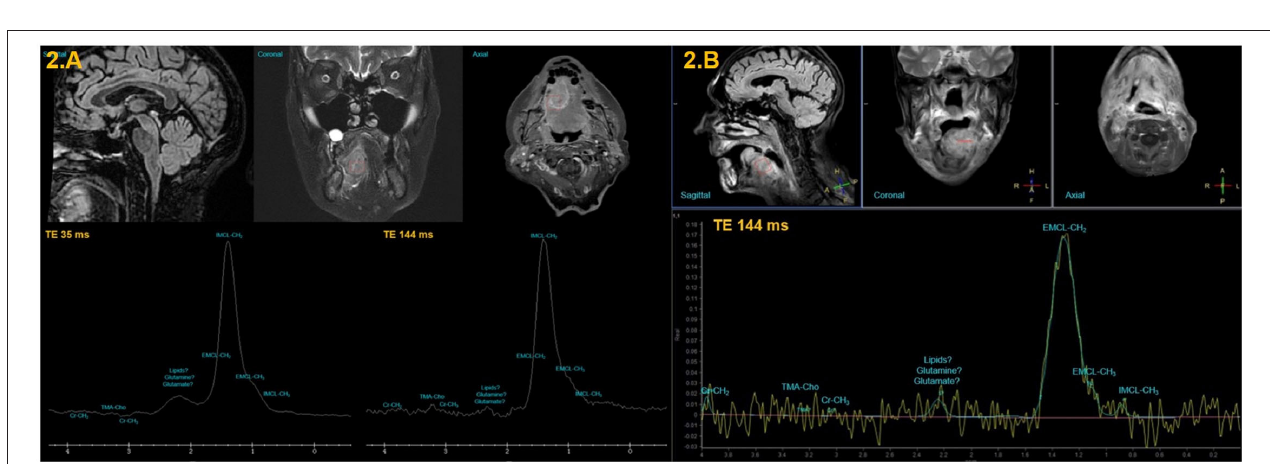
FIGURE 2 | MR images illustrating 1 H-MRS voxel placement in the nontreated tongue SCC (A) and treated tongue SCC (B) and their representative 1 H-MRS spectra.